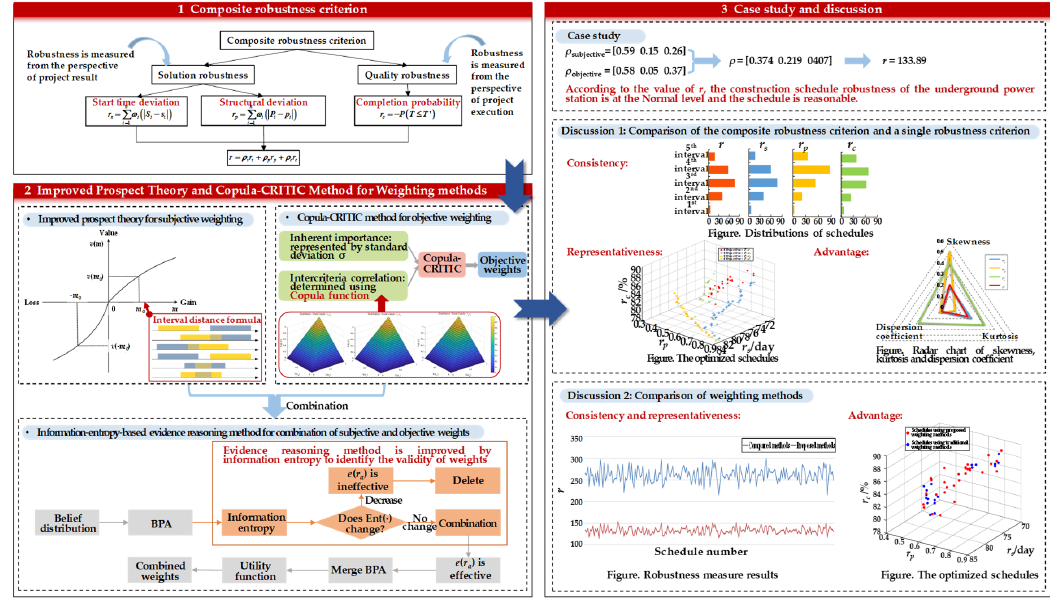
Figure 1. Research framework.